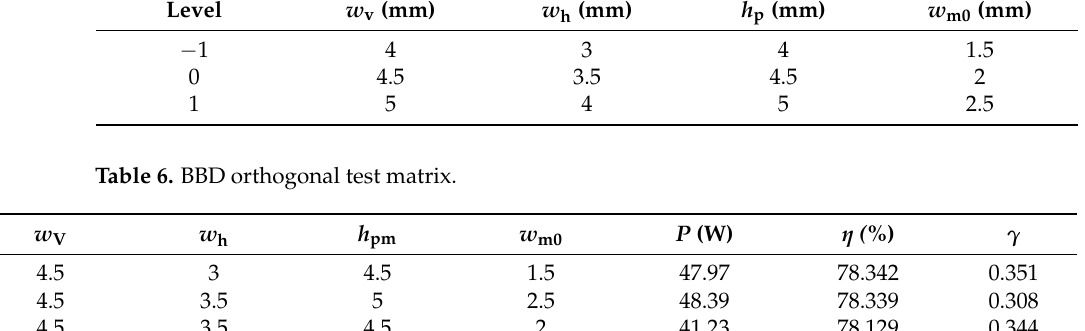
Table 5. Design variable level value.